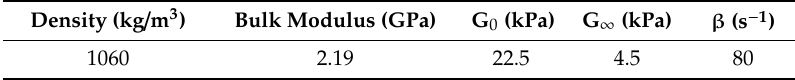
Table 3. Viscoelastic material parameters of the brainstem used in FE modeling [1].